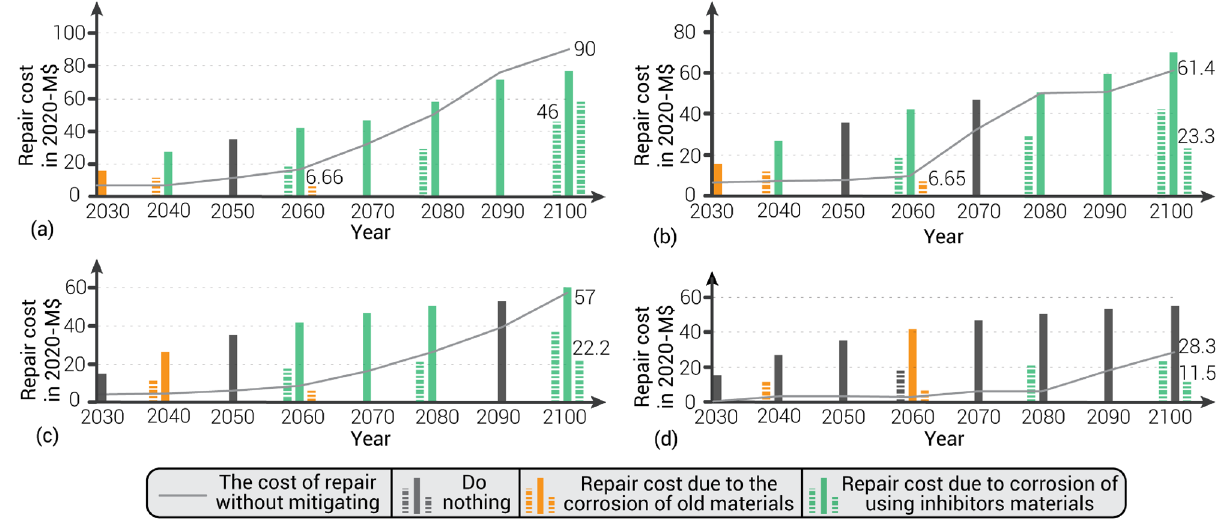
Figure 5. The total accumulated repair costs (in million 2020-$) using 10 years (middle column—option A), 20 years (left dashed column—option B), and 40 years (right dashed column – option C) periodic inspections under ( a ) SW1, ( b ) SW2, ( c ) SW3, and ( d ) SW4